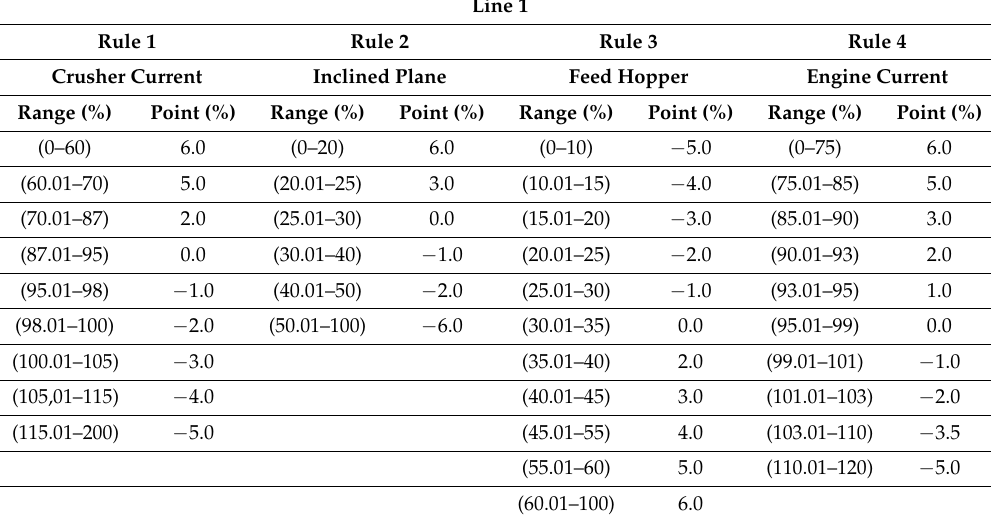
Table 4. Dynamic times K-UCN, Secondary Crusher.